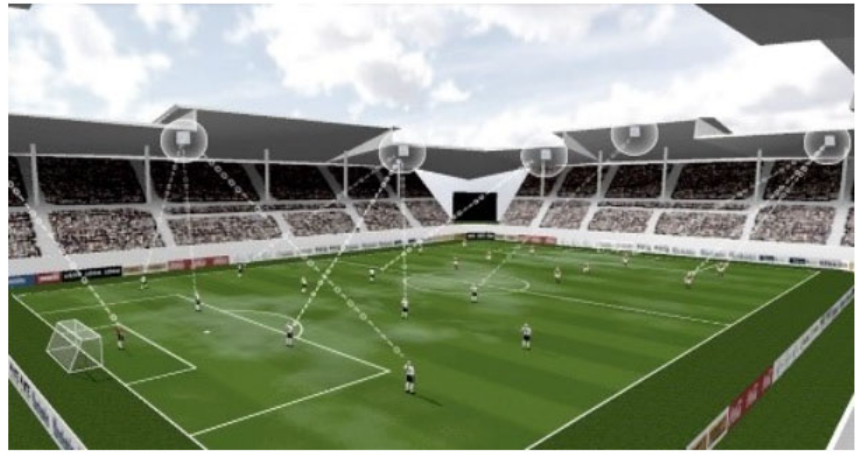
Figure 1. Principles of tracking by the ZXY system. Transponders worn by the players respond to signals sent out from beacons at known positions around the pitch. The players’ positions are calculated from the recorded replies. Photo taken from the ZXY brochure, also available at https://www.nacinc.jp/analysis/sports ‐ tracking/zxy ‐ arena/, accessed on 10 March 2023.